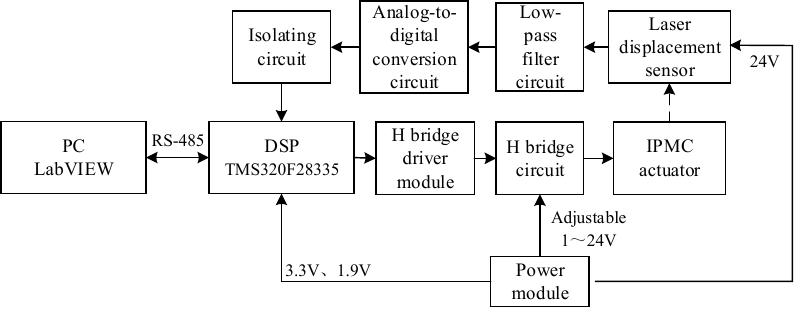
Figure 2. Structure diagram of the IPMC actuator platform.